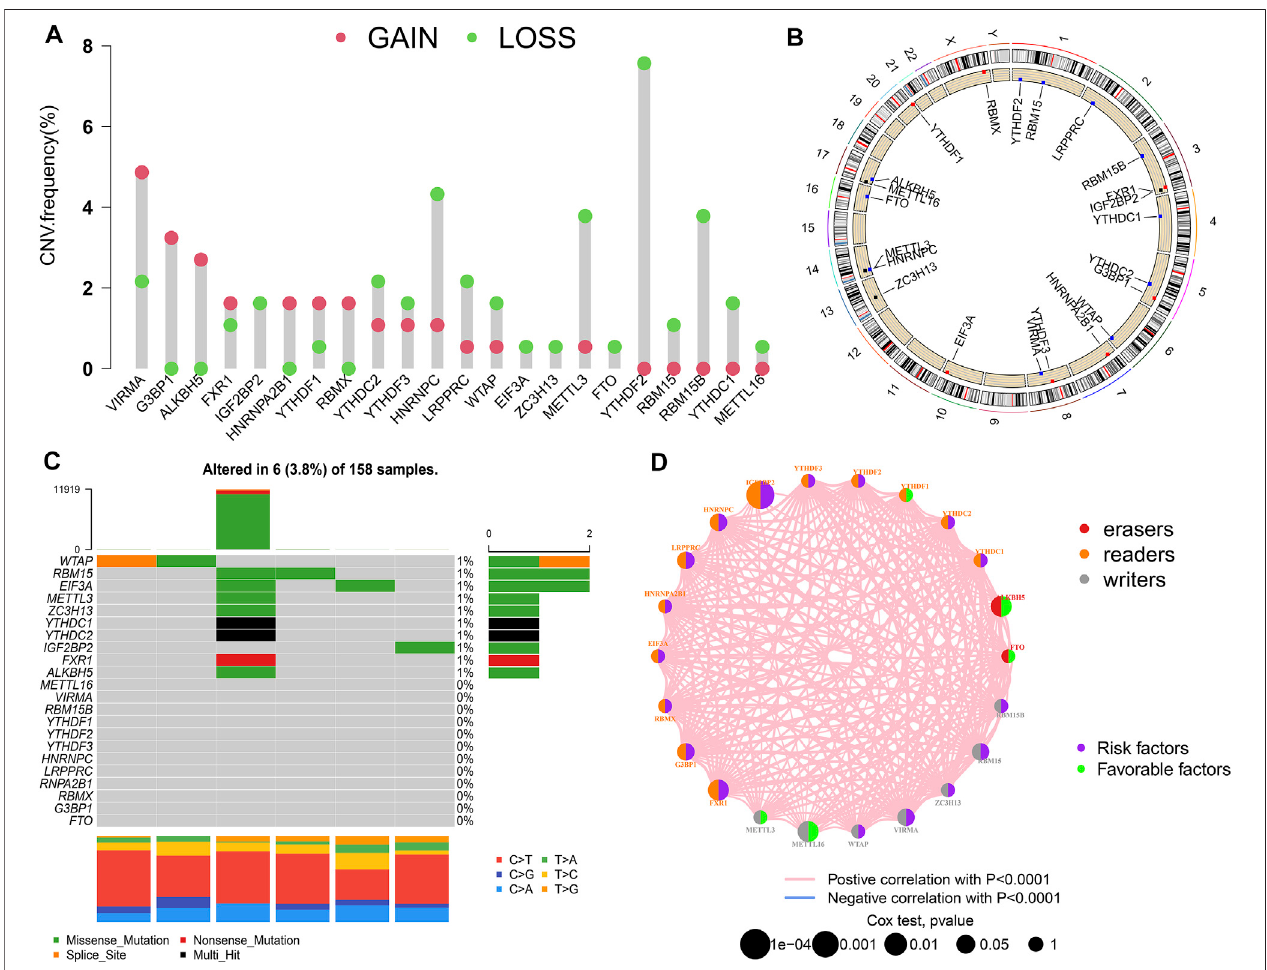
FIGURE 1 | m6A modi fi cation pattern in PAAD. (A) The CNV alteration frequency of 22 m6A regulators in PAAD; (B) The CNV landscape of m6A regulators in 23 pairs of chromosomes; (C) The mutation frequency of m6A regulators in PAAD; (D) Interaction of m6A regulators in PAAD.